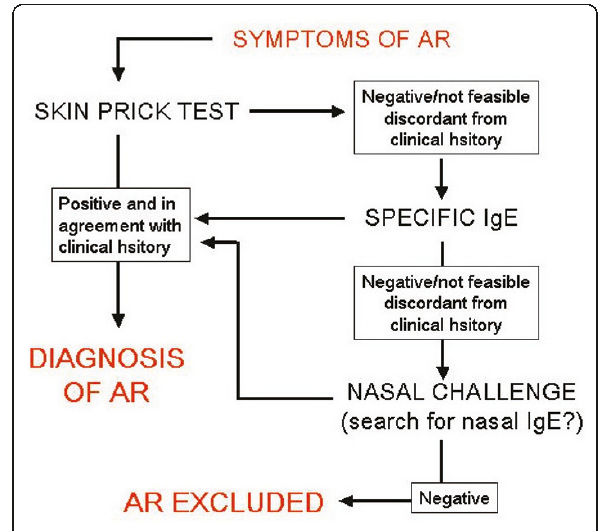
Figure 9 Diagnostic algorithm for the diagnosis of AR .